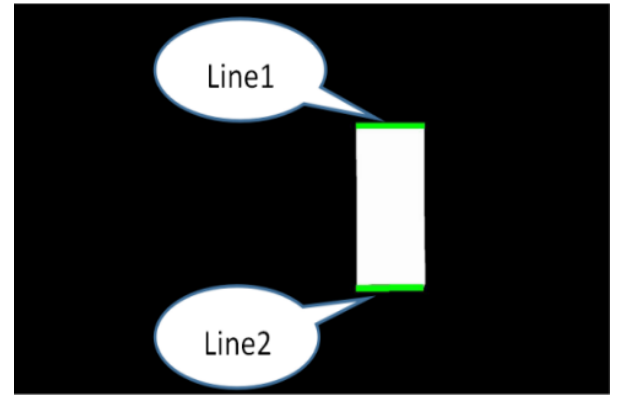
Figure 23. Corrosion operation.